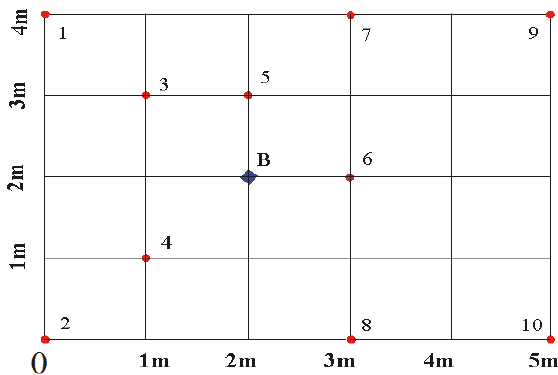
Figure 5: Layout of blasthole and sonic wave monitoring holes.